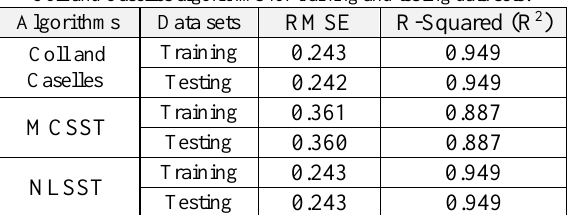
Table 3. Estimated RMSE and R 2 values for MCSST, NLSST and Coll and Caselles algorithms for training and testing data sets